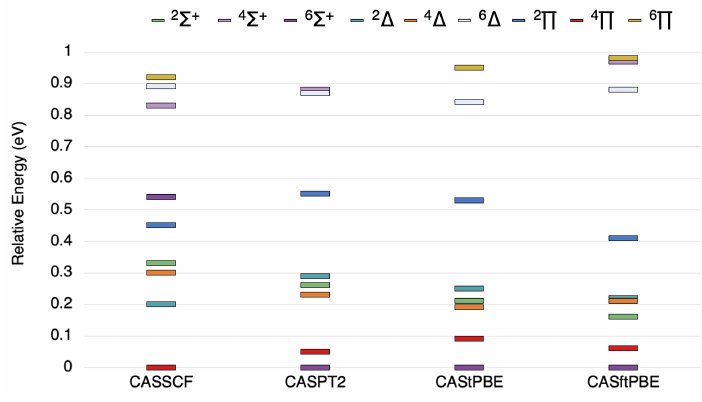
Figure 2. The state ordering of the lowest 6 Σ + , 4 Σ + , 2 Σ + , 6 ∆ , 4 ∆ , 2 ∆ , 6 Π , 4 Π , and 2 Π states states of NbSi as computed by the methods outlined above.